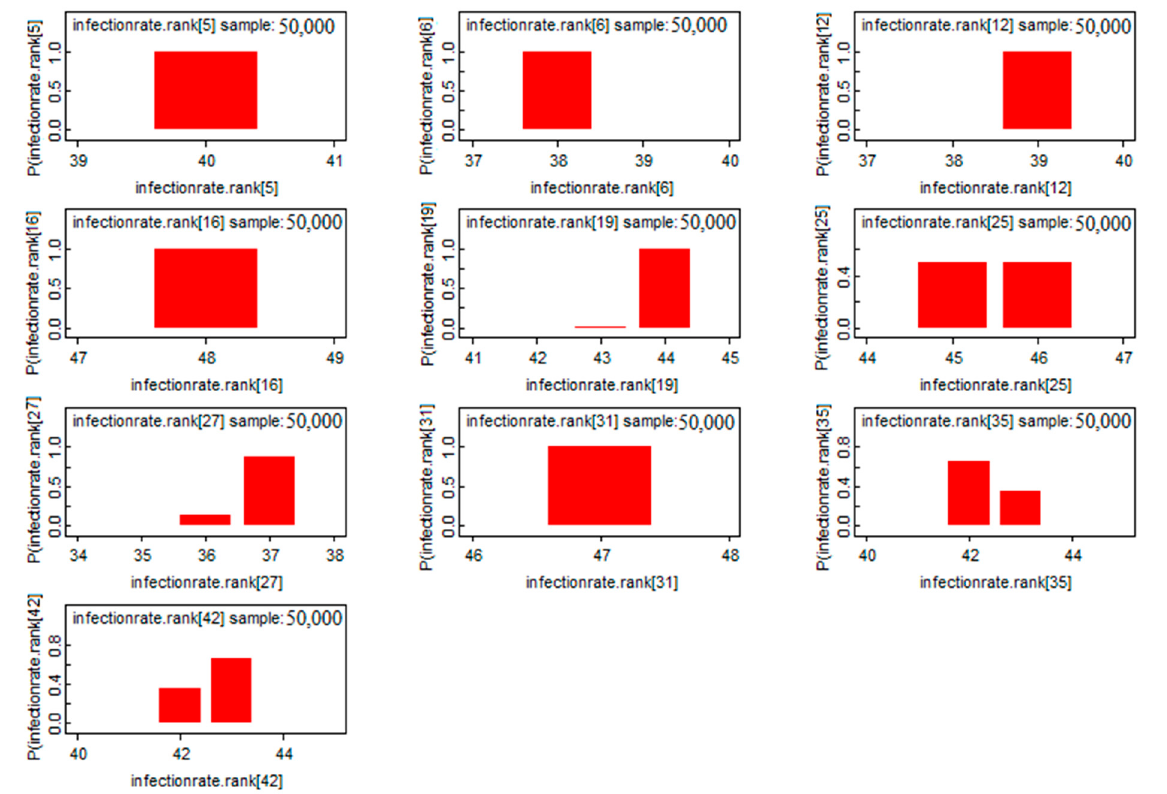
Figure 13. Risk classification of the COVID ‐ 19 infection rate of the top 10 provinces.